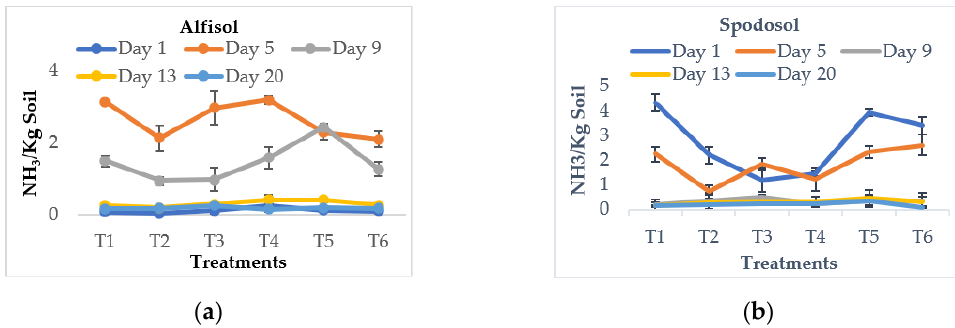
Figure 6. Effect of treatments on NH 3 volatilization at different intervals from ( a ) Alfisol soil and ( b ) Spodosol soil.